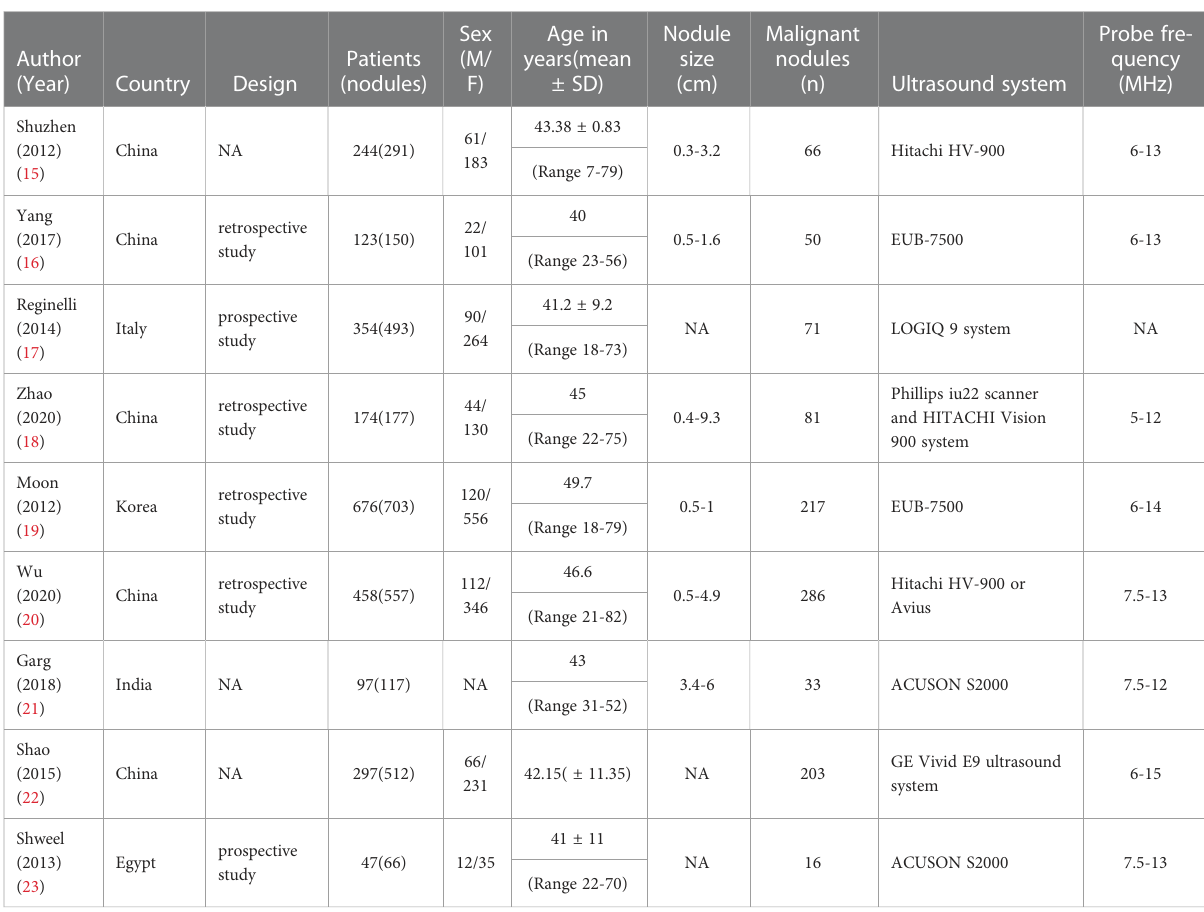
TABLE 1 Summary of included study characteristics.